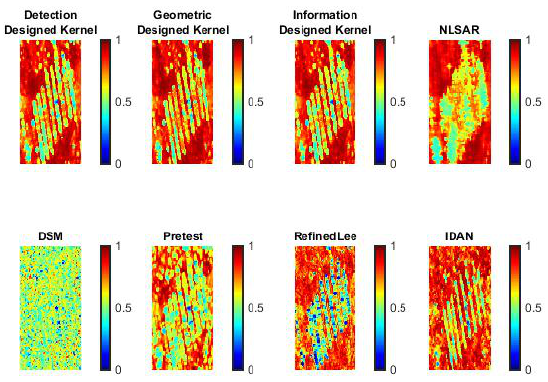
Figure 8. Decomposed alpha of the some pattern in filtered data